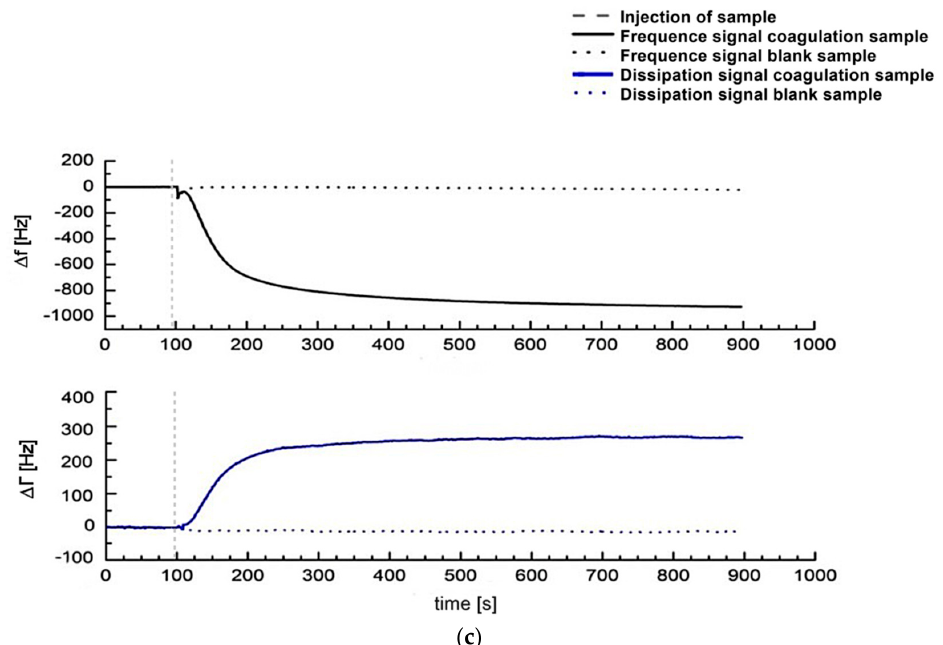
Figure 1. ( a ) Illustration of the general idea of a QCM-based coagulation measurement based on the Clauss assay on a pre-coated quartz (PPP); ( b ) Experimental series with consecutive injection of three blank samples (PPP + imidazole buffer, 1:10 diluted) and one coagulation sample (PPP + thrombin reagent, 1:10 diluted) from healthy donor I into the measurement chamber using healthy donor’s plasma and a blank quartz surface cleaned in acetone. Dotted vertical lines: script-automated injection of the mixed samples to the quartz chamber by pump that lasted several seconds. Then the pump was stopped. Arrows: new start of pump with imidazole buffer flow after each measurement in order to proceed with the experimental series until the injection of the next mixed sample; ( c ) 1:10 diluted measurements with coagulation sample (solid line, PPP + thrombin reagent) and blank sample (dotted line, PPP + imidazole buffer) of healthy donor II using a pre-coated quartz surface with 1:10 diluted donor’s own PPP. Vertical line: script-automated injection of the mixed samples to the quartz chamber by pump that lasted several seconds. Then the pump was stopped.